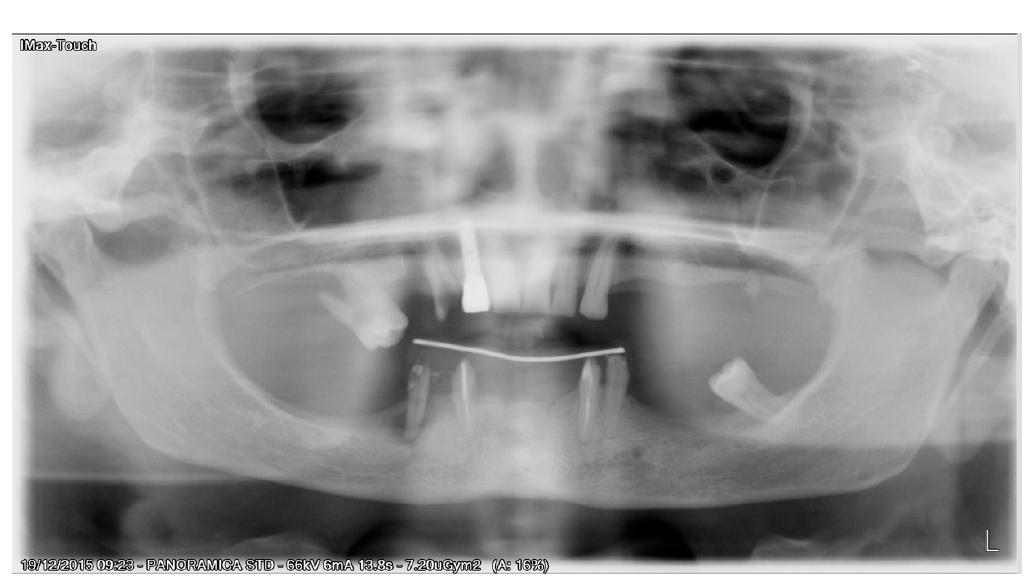
Figure 1. Preoperative panoramic X-ray.